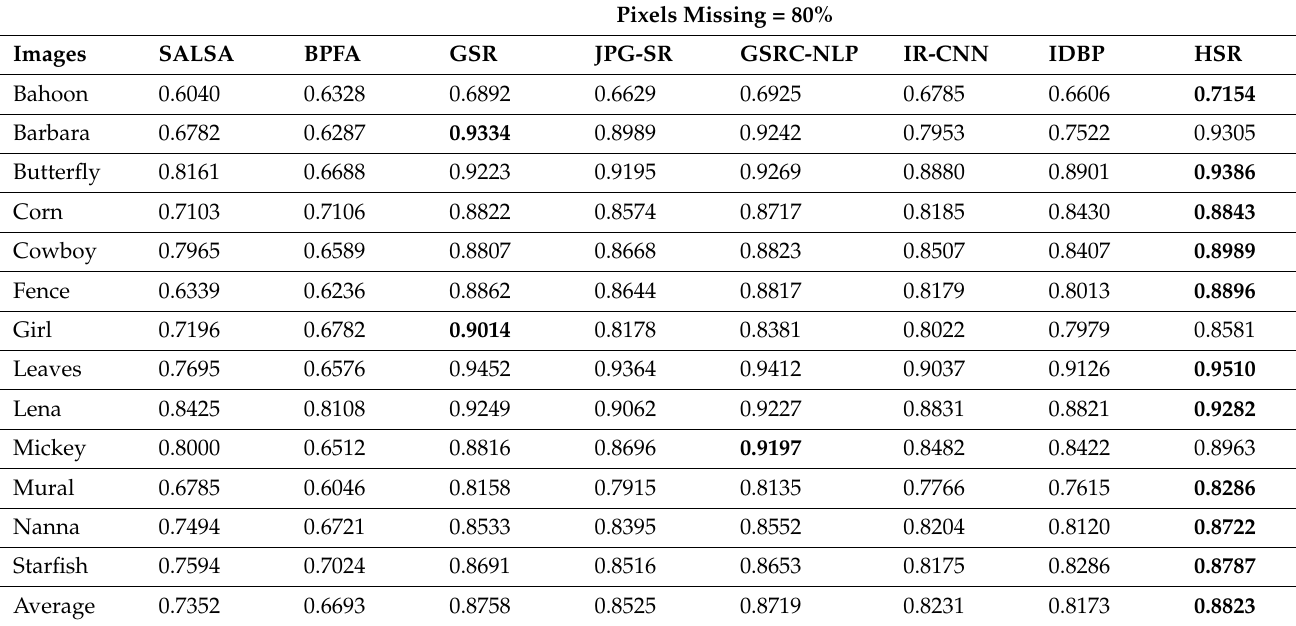
Table 5. SSIM values of our proposed HSR model and other comparison models after image restora- tion with pixels missing rate 80%.